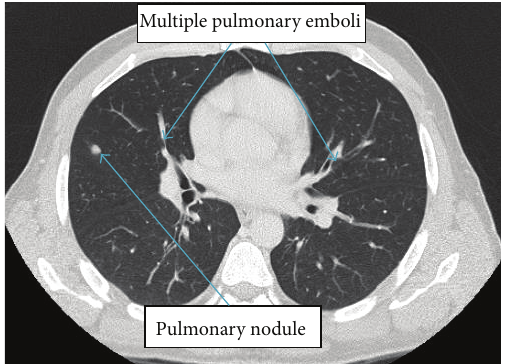
Figure 1: Bilateral pulmonary emboli with pulmonary nodule.